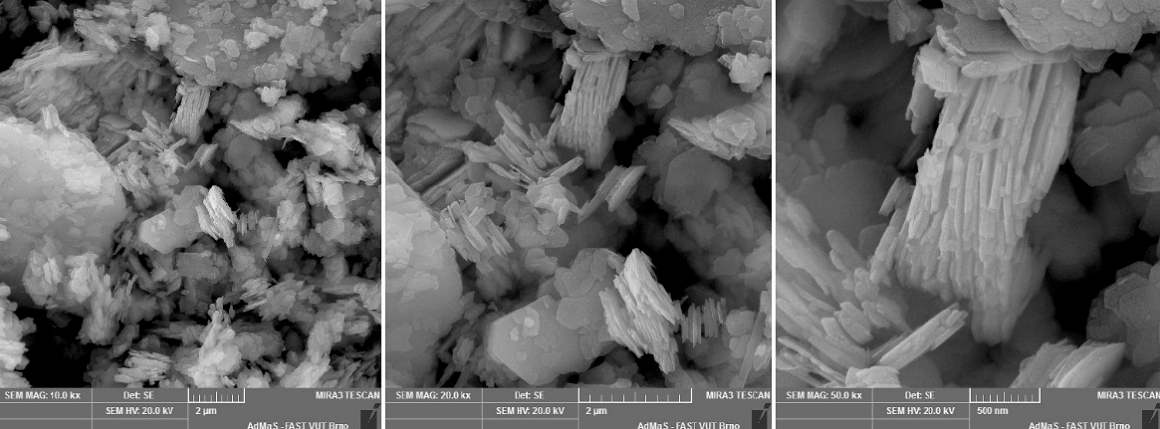
Figure A3. KN-83 floated kaolin.